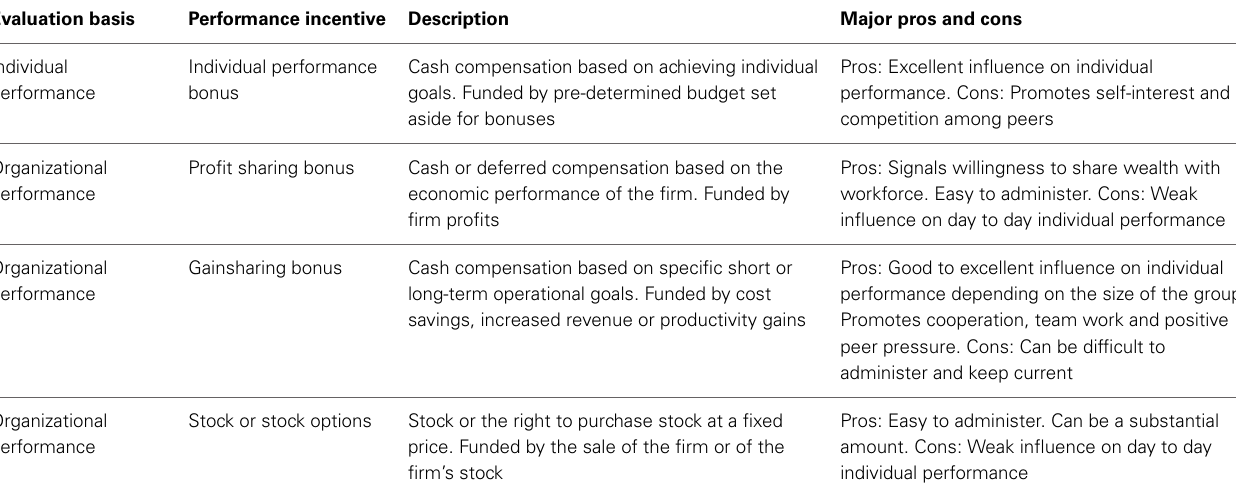
Table 1 | Common performance incentives for